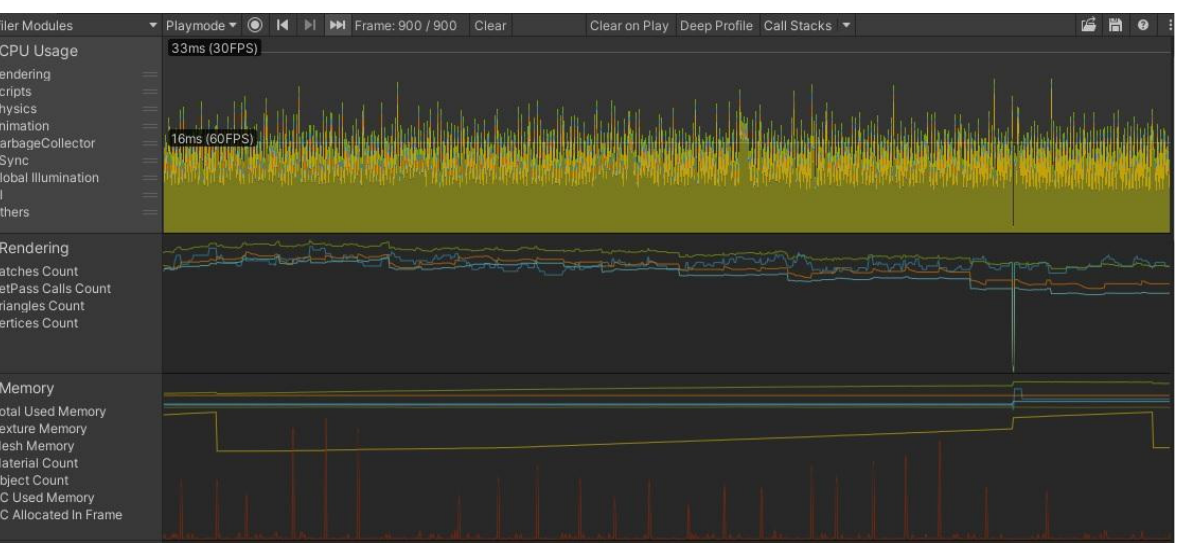
Figure 13. Profiler results for the gameplay of the optimized version of the game.